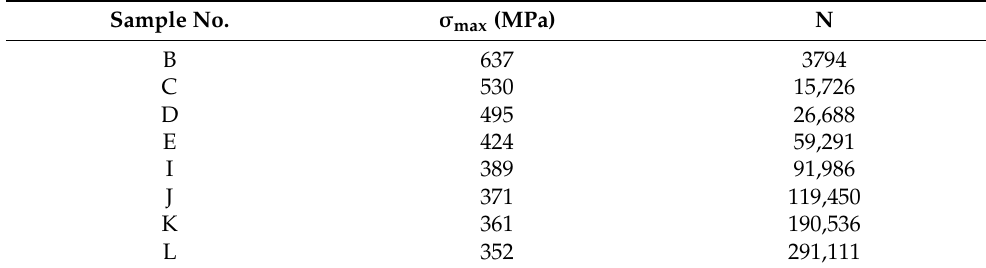
Table 2. Maximum stress ( σ max ) and the number of cycles up to failure (N), obtained for Ni/CrC coated 4340 steel samples.